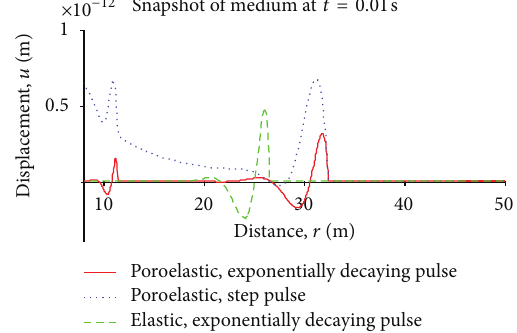
Figure 8: Displacement wave in the media at a particular time, exponentially decaying pulse case.